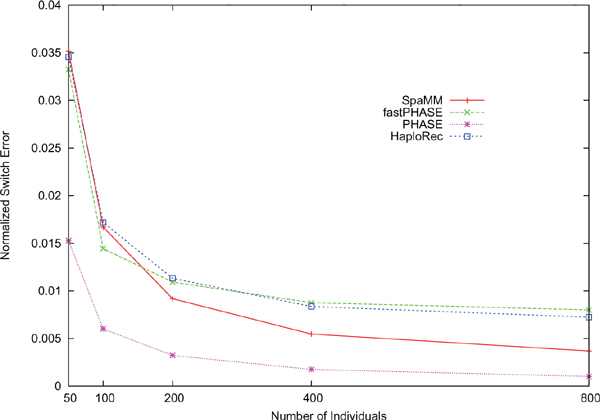
Reconstruction accuracy as a function of the number of samples available. Average normalized switch error on the Hudson datasets as a function of the number of individuals for SpaMM, fastPHASE, PHASE and HaploRec is shown. Results are averaged over 50 datasets.